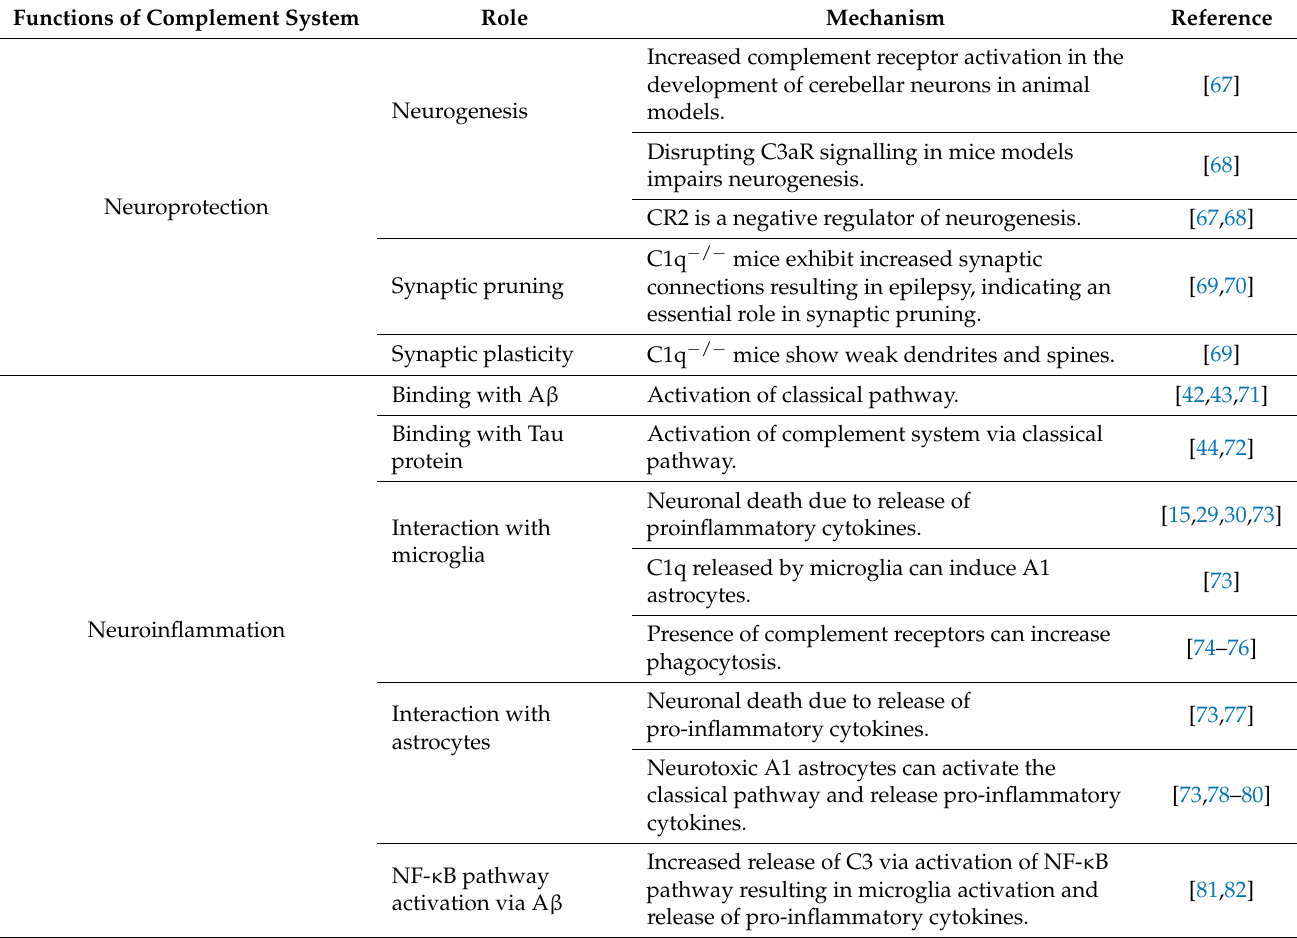
Table 1. Functions of complement system in the central nervous